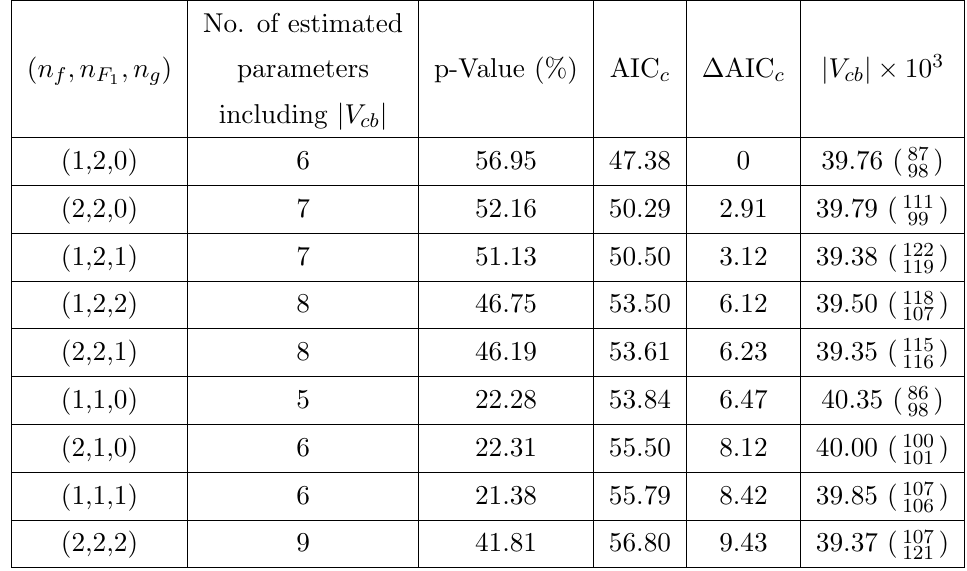
Table 3. Ranking of various ( n f ; n F ; n g ) scenarios with (cid:1)AIC c . 10. For details, see the text. 1 n f = 1 ; n F = 2 ; n g = 0 1